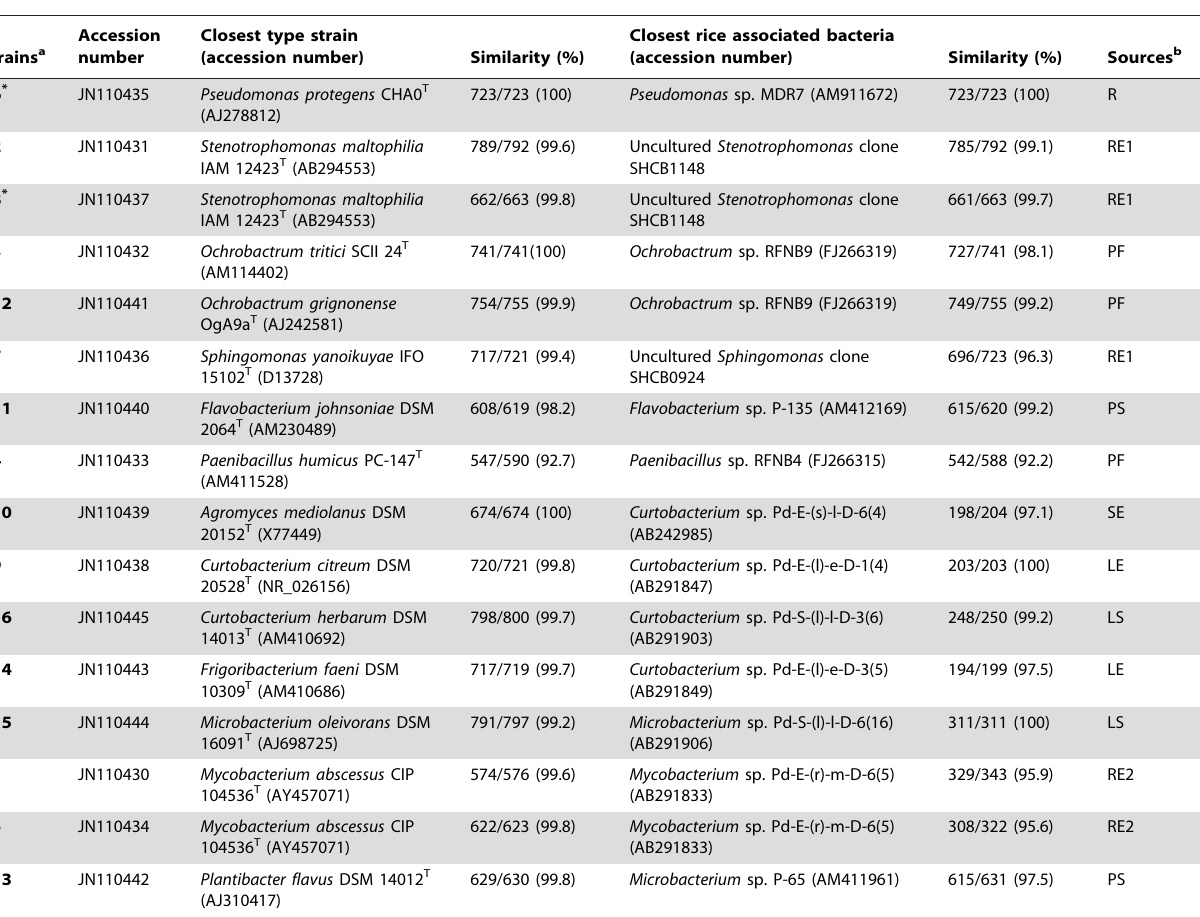
Table 1. Identification of isolated seed-borne